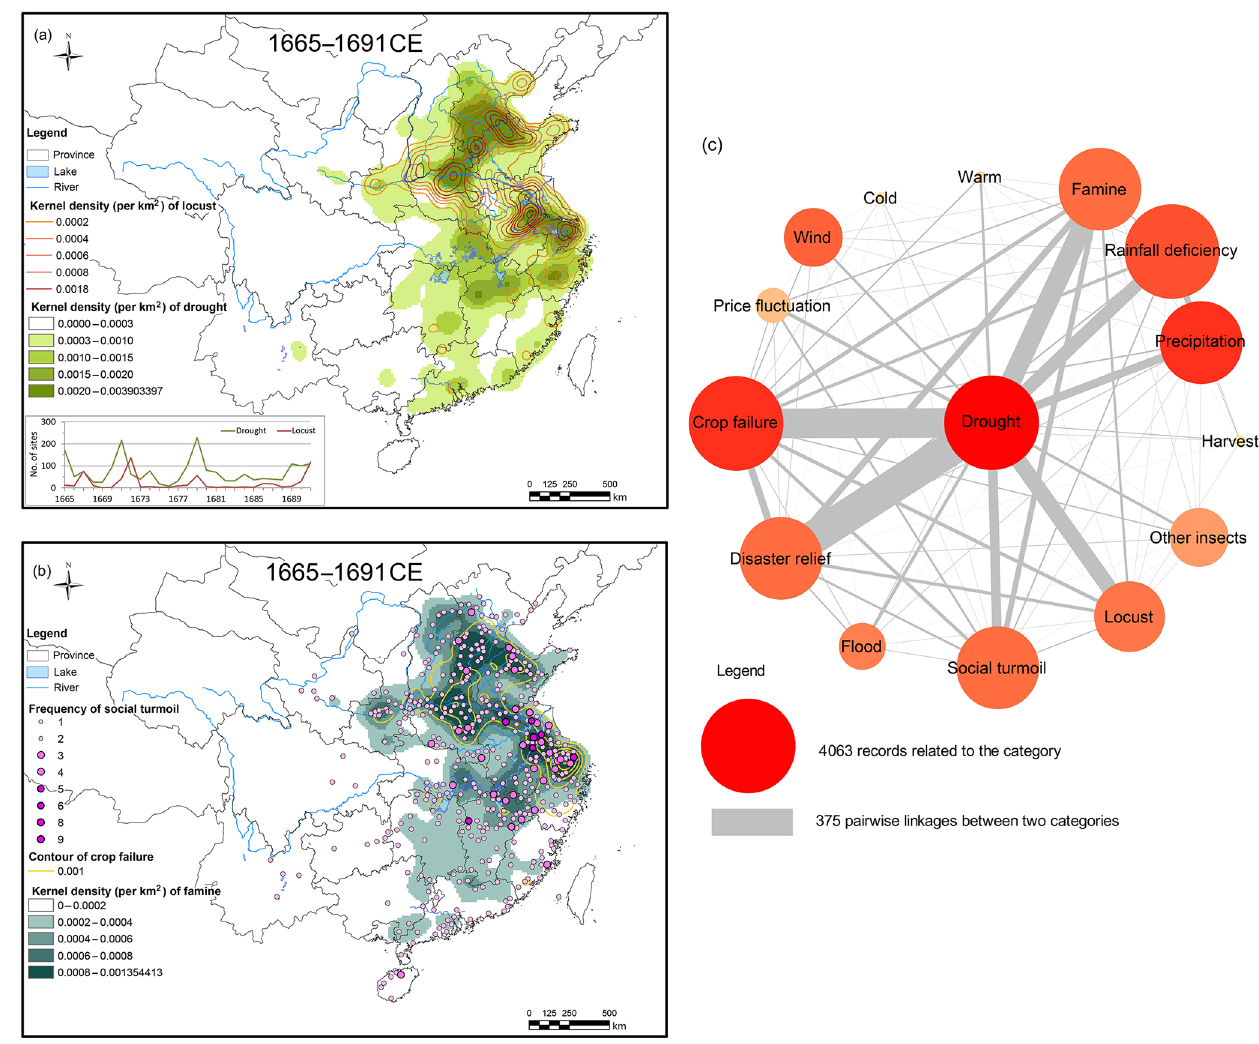
Figure 7. Spatial distribution of the kernel density function of drought and locust outbreaks (a) and social turmoil (b) , and the social network chart (c) in the drought period